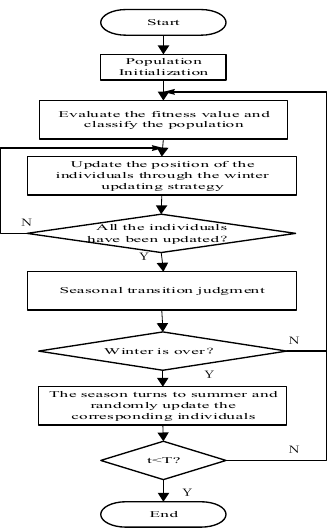
Figure 1. The procedure of the standard squirrel search algorithm (SSA).